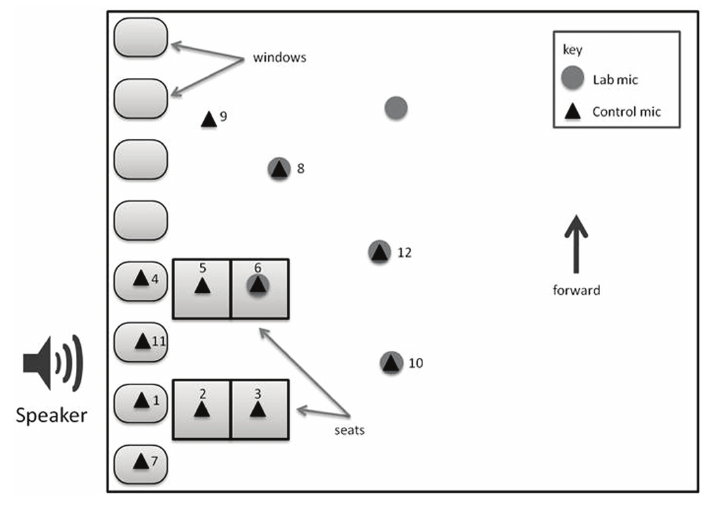
Fig. 10. Schematic of